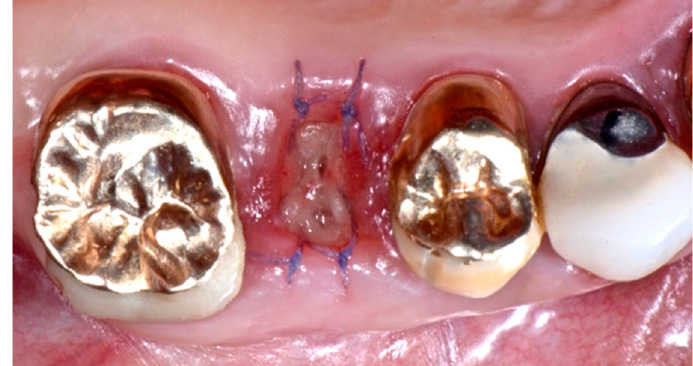
Figure 7. Intra-oral clinical view after 1 week from the intervention. Partial re-epithelization can be observed over the alveolar socket.